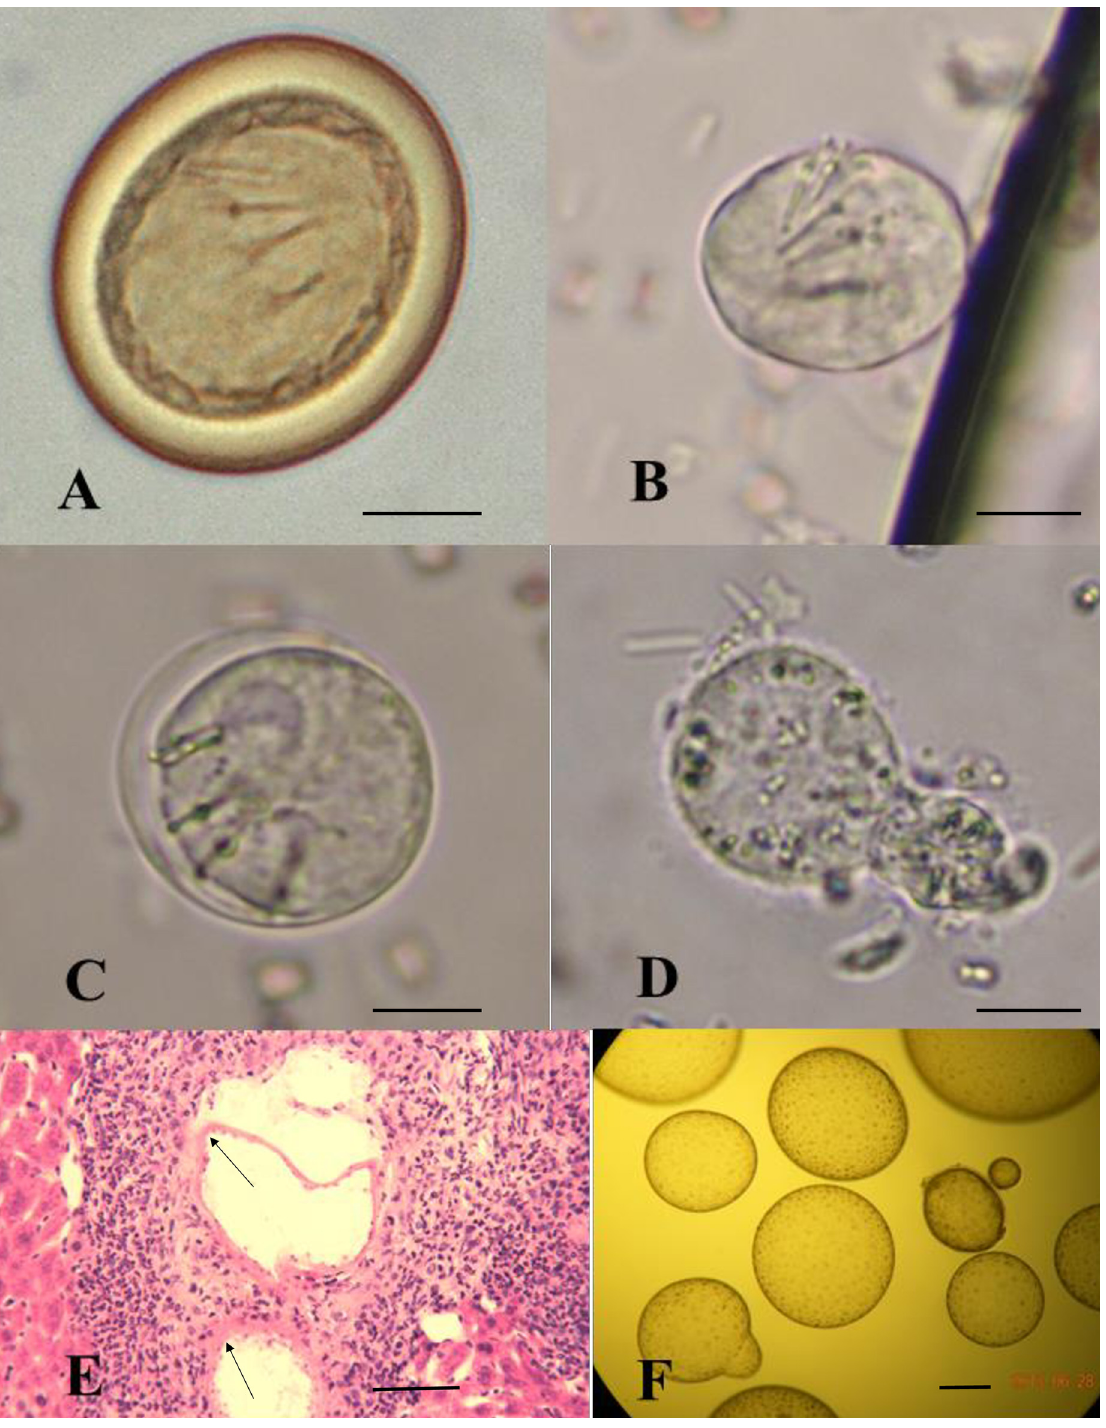
Fig 1. Morphology of different life cycle stages of E . multilocularis . A: Egg; B: Oncospheres (non-activated); C: Oncospheres (activating) with the hooks dispersive and body swelling; D: Oncospheres (activated) with the hooks aggregation in the smaller lobe after 24 hours activation; E: 4-week metacestodes miniature vesicles; F: Metacestodes small vesicles cultivated in vitro; Bar: 10 μ m (A-E), 1mm (F); Arrowhead: Miniature vesicles.